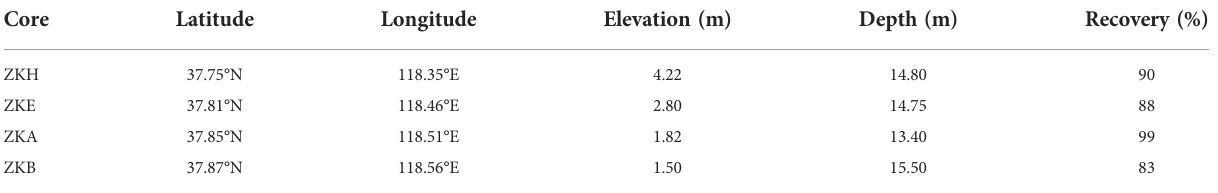
TABLE 1 Location, elevation, depth and recovery for each